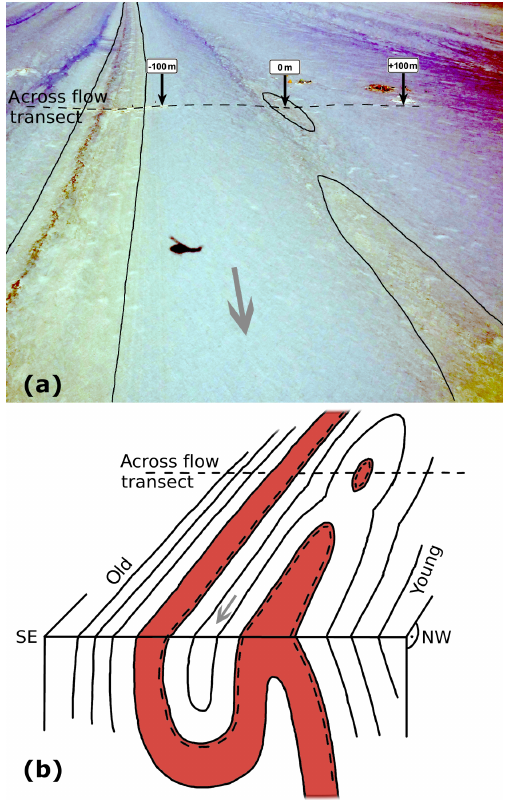
Figure 5. Folding on Taylor Glacier. (a) Photo of the across-flow transect sampling area showing two limbs of the dusty band. Color settings were adjusted to enhance the color differences. The solid black line marks the approximate boundary of the dusty band. The dashed black line marks the across-glacier transect including dis- tance markers. The camp is visible in the upper right. Glacier flow is from top to bottom and indicated by gray arrows. For scale, the southeastern limb of the dusty band, on the left in the photo, is ∼ 60m wide. Photo by Ed Brook. (b) Sketch of the z -fold, showing its surface expression and a cross section. The dusty band is shown in